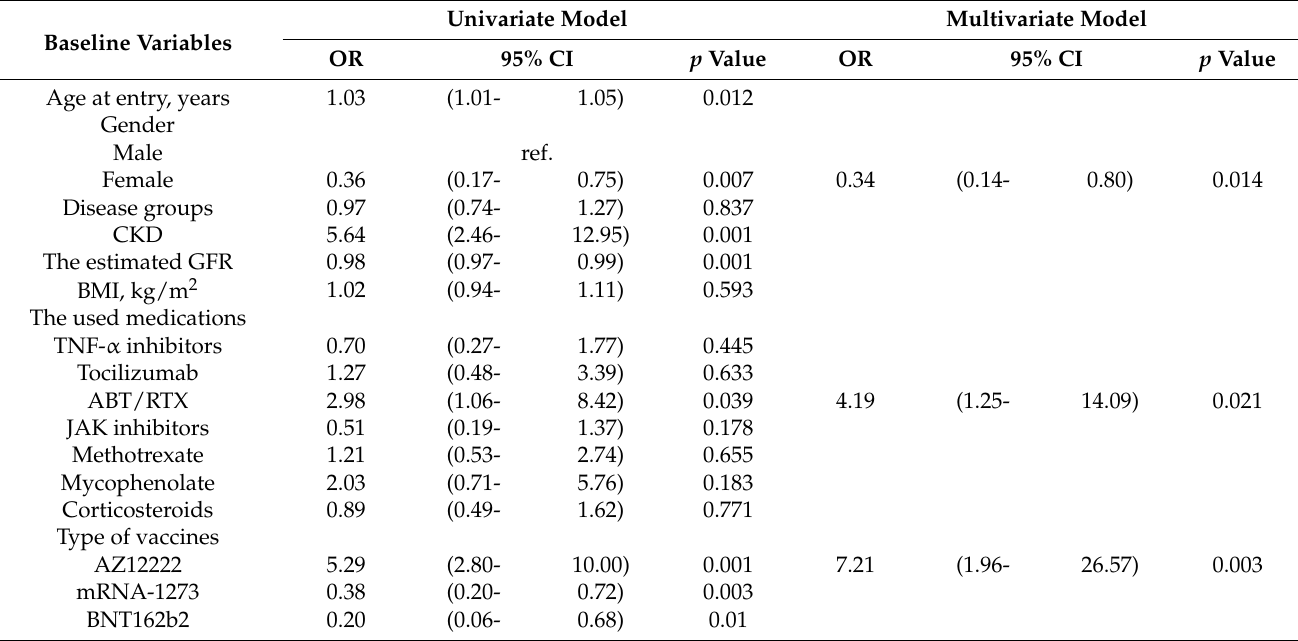
Table 2. Logistic regression analysis for predicting the lack of